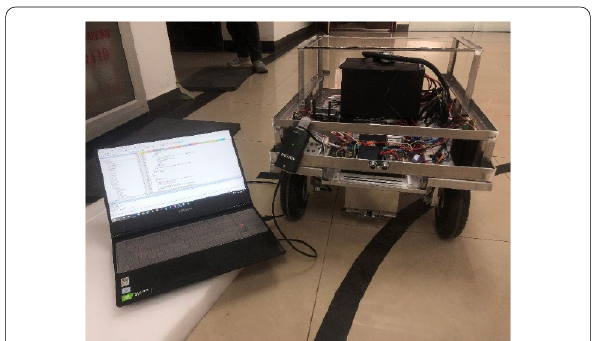
Figure 12 Experimental robot platform